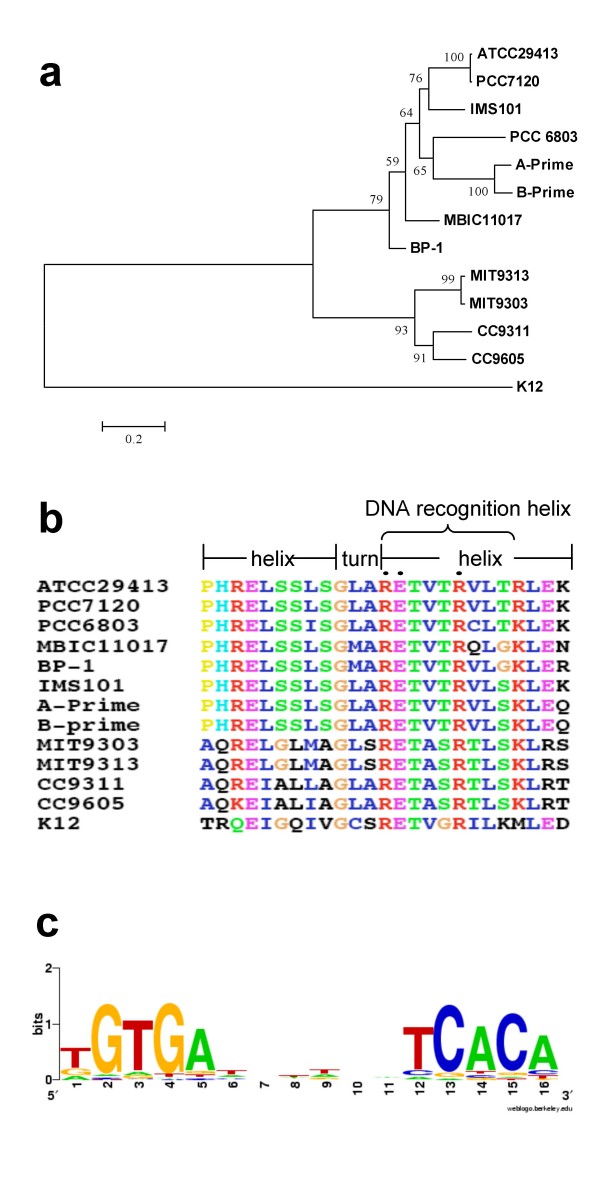
(a) Phylogenetic relationships of CRPs from 12 cyanobacterial genomes. The tree is rooted with the CRP of E. coli K12, and bootstrap values are shown on the nodes. (b) Multiple sequence alignments of the DNA binding domains of the 12 cyanobacterial CRPs. The DNA binding domains contains a helix-turn-helix motif in which residues 1–9 form the first helix, residues 10–12 form the turn and residues 13–25 form the second helix. Particularly, residues 13–21 form the DNA recognition helix with residues 13, 14, 18 (indicated by solid dots) being in direct contact with DNA through forming hydrogen bonds with it [39]. (c). Logo representation of the profile of the 112 putative CRP binding sites predicted by the phylogenetic footprinting technique. Logo was generated by the Weblogo server [49].